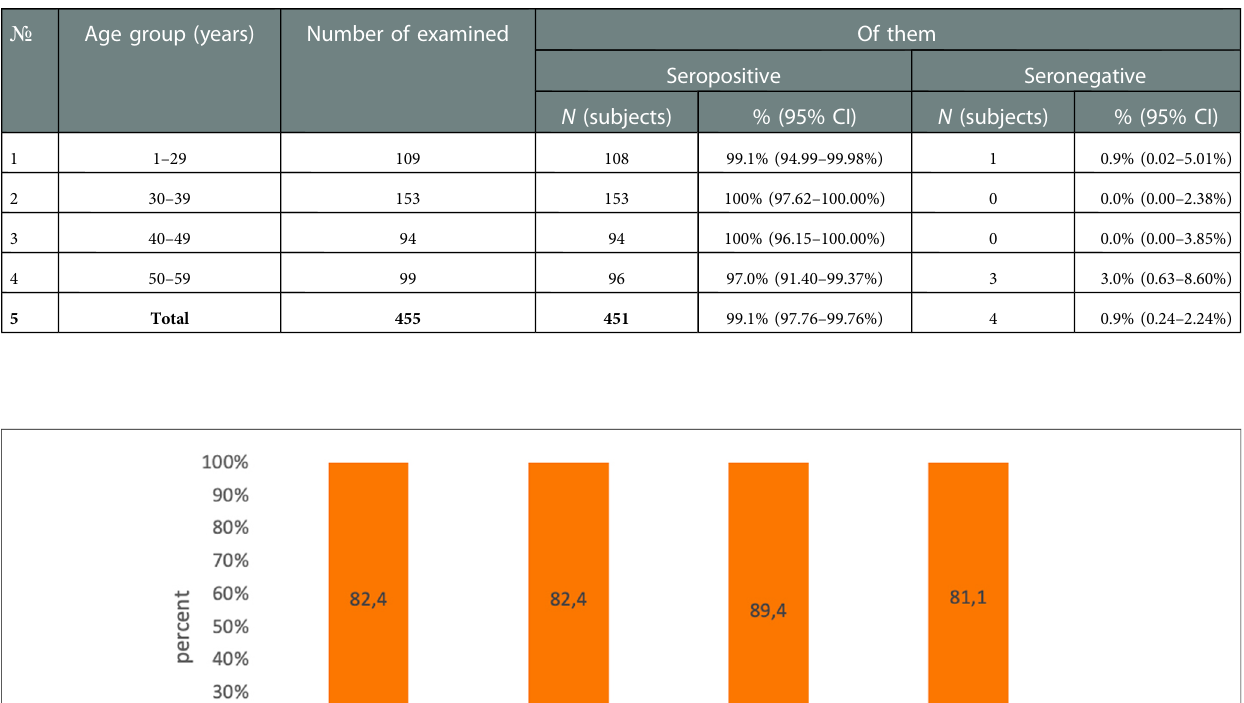
TABLE 4 IgG blood serum levels to diphtheria in healthcare professionals.